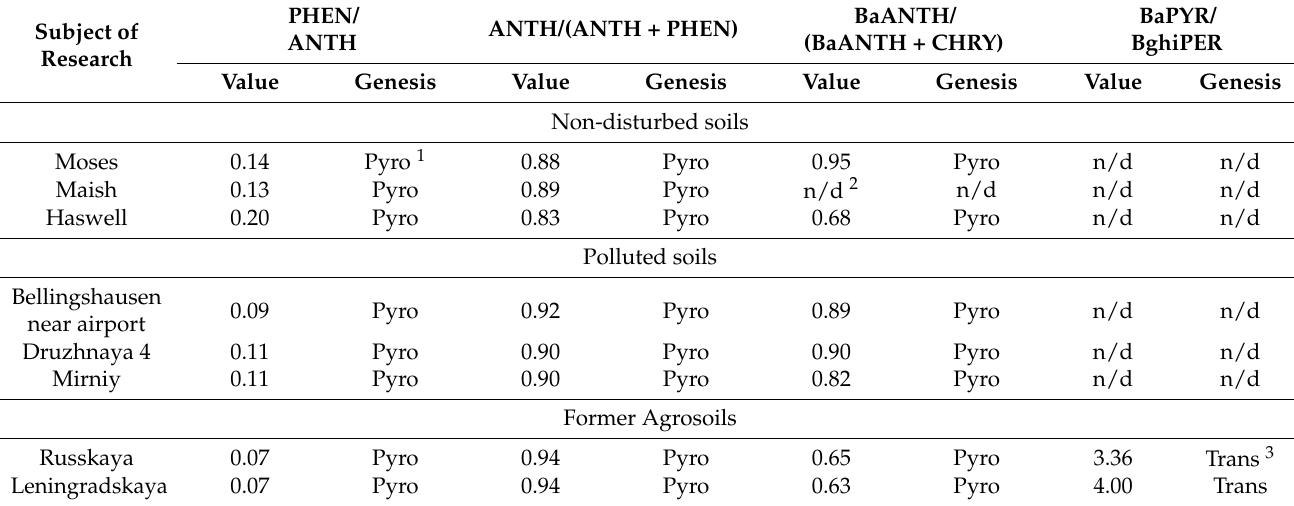
Table 2. Values of indicator (isomeric) ratios and possible origin sources of